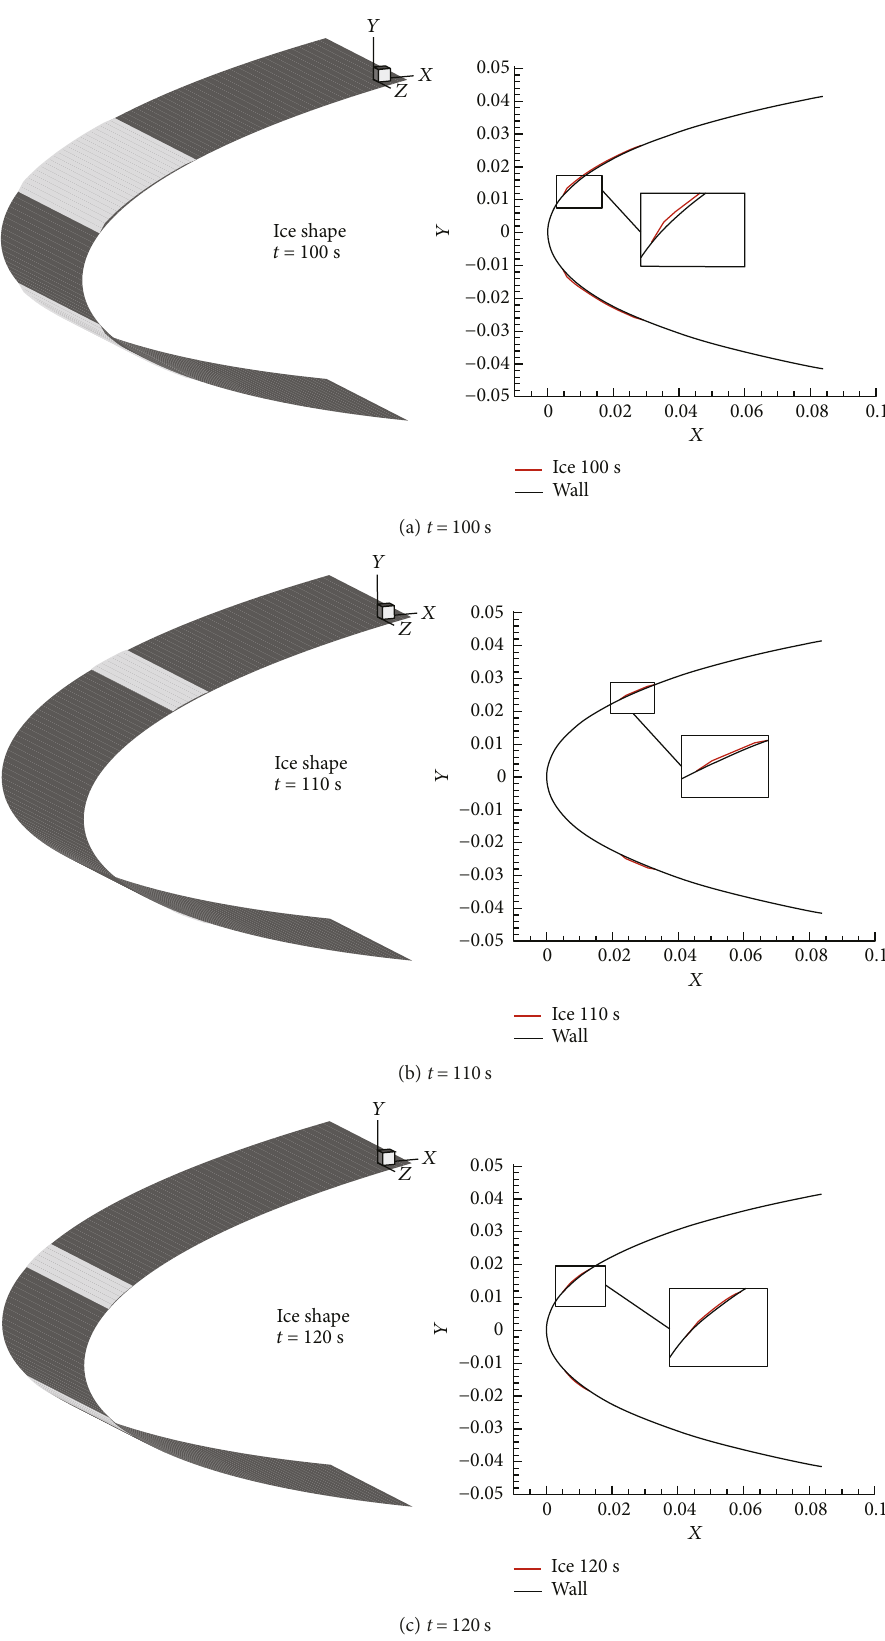
Figure 9: Simulated ice shape following NASA